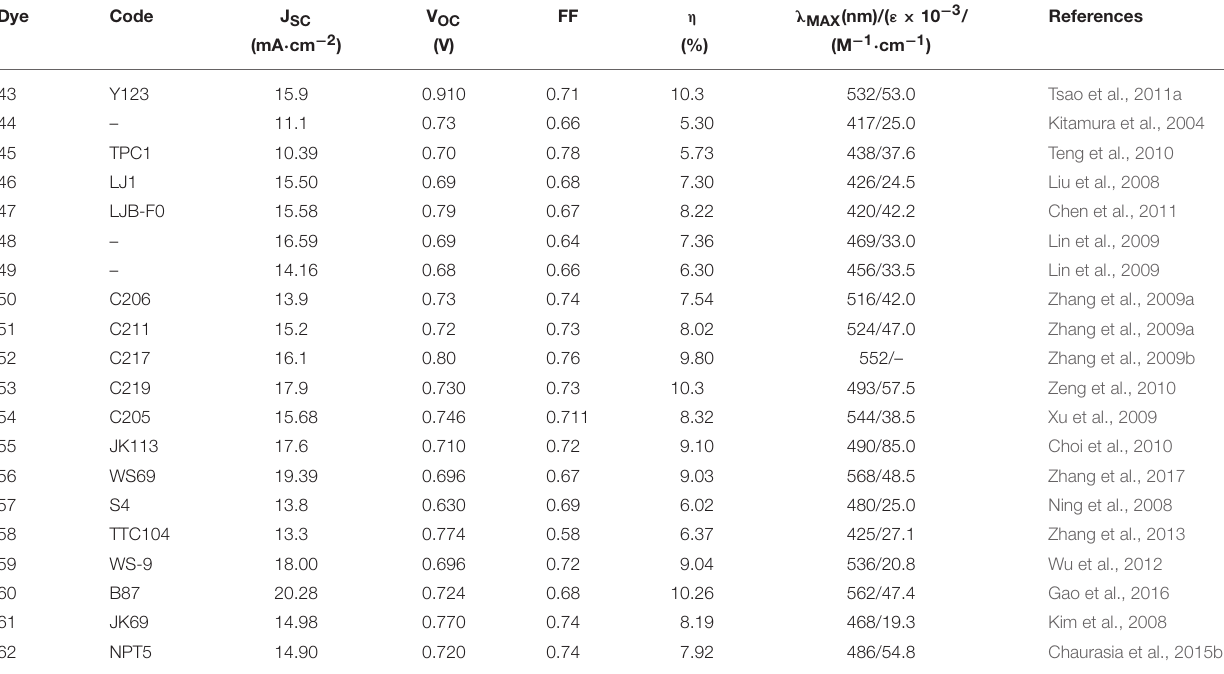
TABLE 3 | Photovoltaics parameters of DSSC sensitized with metal free sensitizers 43–62.